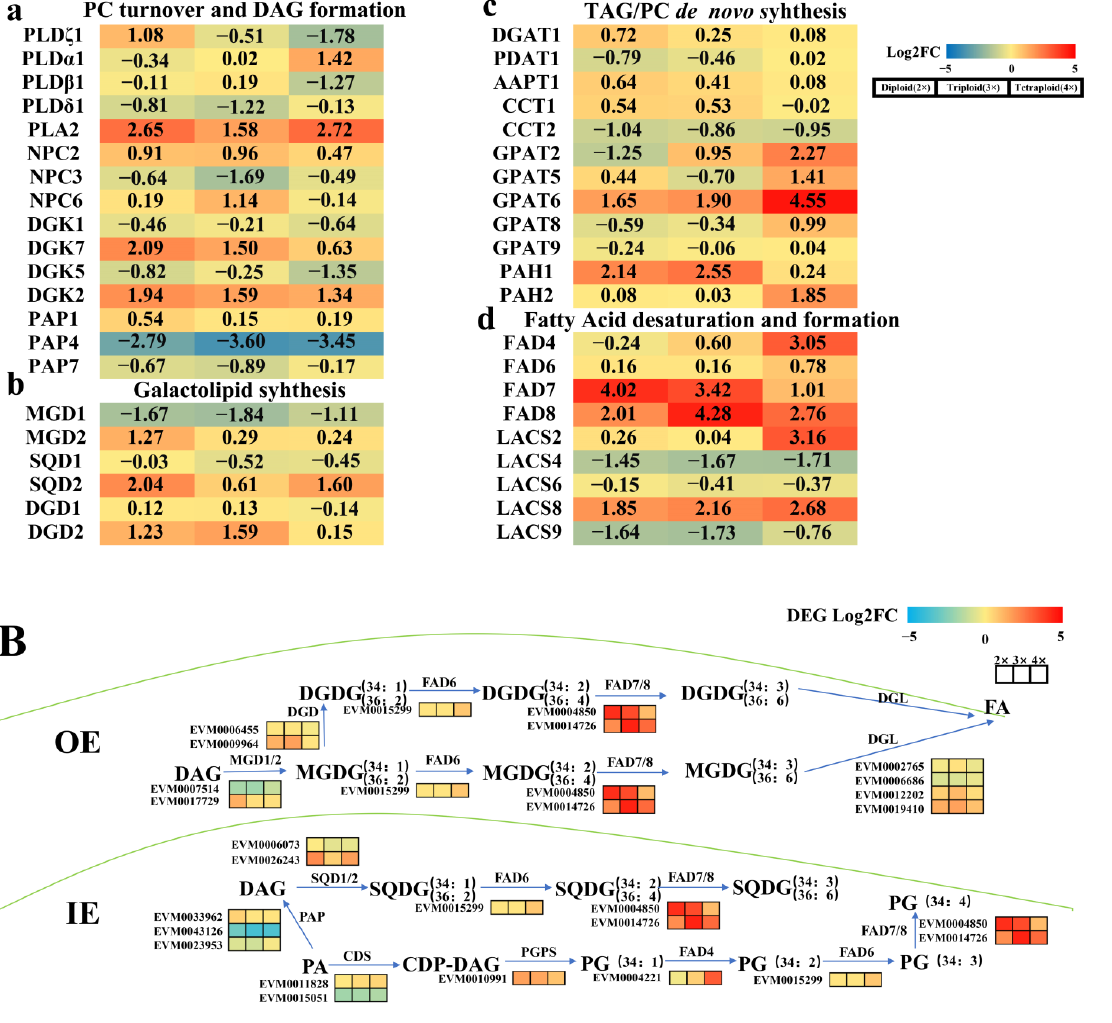
Figure 1. Differentially expressed genes (DEGs) and metabolic networks of major lipid metabolic pathways in loquat leaves under low-temperature stress (−3 °C). ( A ) Differentially expressed genes (DEGs) in loquat leaves under low-temperature stress (−3 °C). The number in each color block rep- resents the Log2 (fold-change) of the corresponding genes, and the negative number represents down-regulated DEGs. The color scale was provided. Red indicates a higher expression level, and blue indicates a lower expression level. ( B ) Gene-metabolite network illustrating membrane lipid metabolism in loquat under low-temperatur stress. The glycerolipid synthesis pathway is mapped, and the genes and lipid metabolites involved are symbolized. The relative expression levels of se- lected genes are labelled as heat map icons. The color scale is provided. Red indicates a higher ex- pression level, and green indicates a lower expression level. OE, outer envelope; IE, inner envelope; PA, phosphatidic acid; CDP-DAG, cytidine diphosphate diacylglycerol; DAG, diacylglycerol; FA,